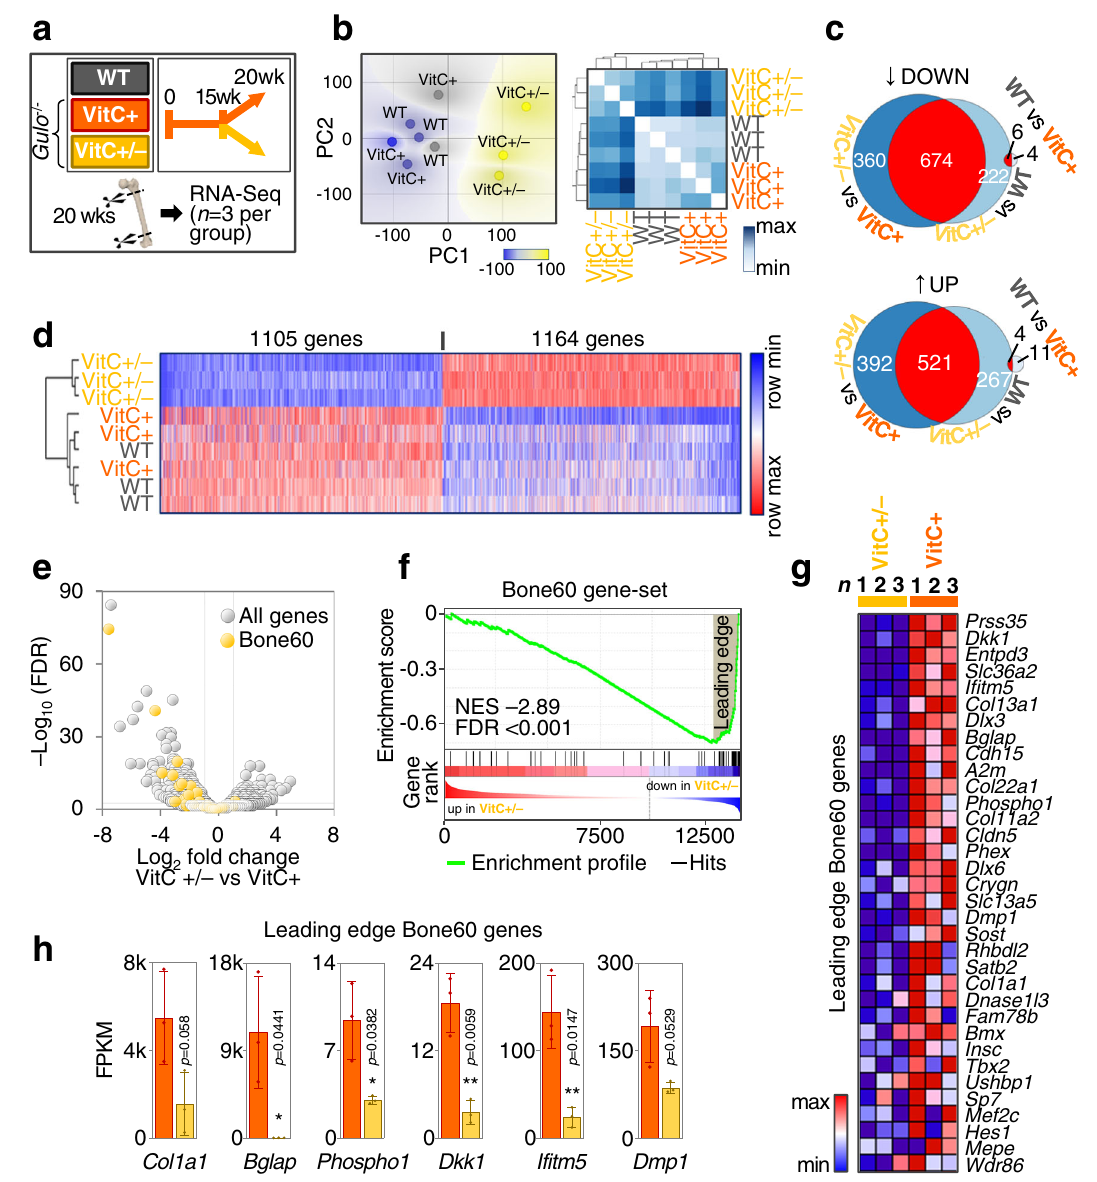
Fig. 1 | Vitamin C de fi ciency causes vast transcriptional changes in bone. a Experimentalsetup;wk,week. b RNA-seqanalysisoffemoralboneusingprincipal component analysis and hierarchical clustering. c Venn diagrams depicting differ- entially expressed genes ( p -adj<0.05). d Gene expression heatmap displaying differentially expressed genes between VitC-positive and VitC-negative mice ( p - adj<0.05). e – h Volcano plot and GSEA analysis of the Bone60 gene-set in VitC±